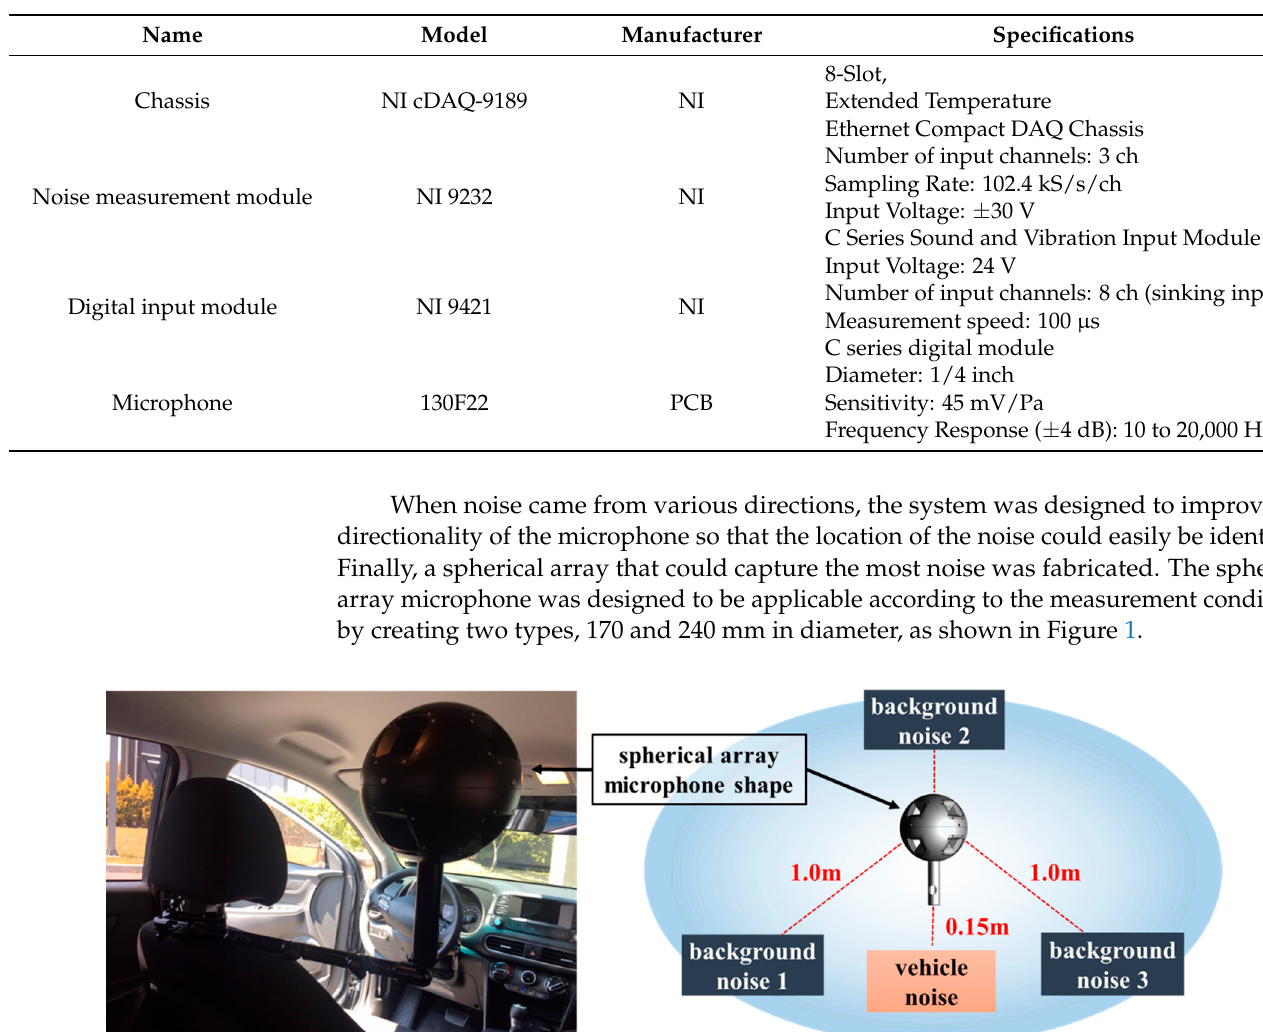
Table 1. Measurement system configuration and detailed specifications.